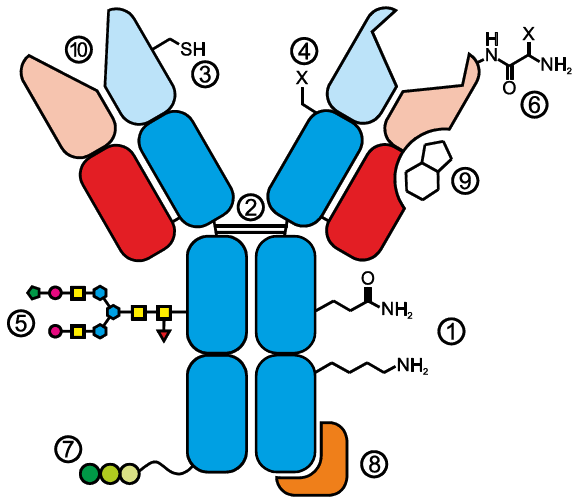
Figure 1. Antibody conjugates can be generated by targeting natural amino acids (1) including interchain disulfides (2), engineered cysteines (3), non-natural amino acids (4), the carbohydrate moiety (5), the N-terminus of heavy and light chain (6) or engineered tags (7). Strong protein-protein interaction, i.e. , Fc-binding domains (FcBD) can be used to form non- covalent antibody conjugates (8). Additionally, the nucleotide binding site (NBS) is a valuable antibody modification site for photoaffinity labeling (9) and antibodies with catalytic activity (10) can be exploited to form bioconjugates where the coupled pharmacophore, e.g., a peptide assumes the targeting function and the antibody acts as a cargo